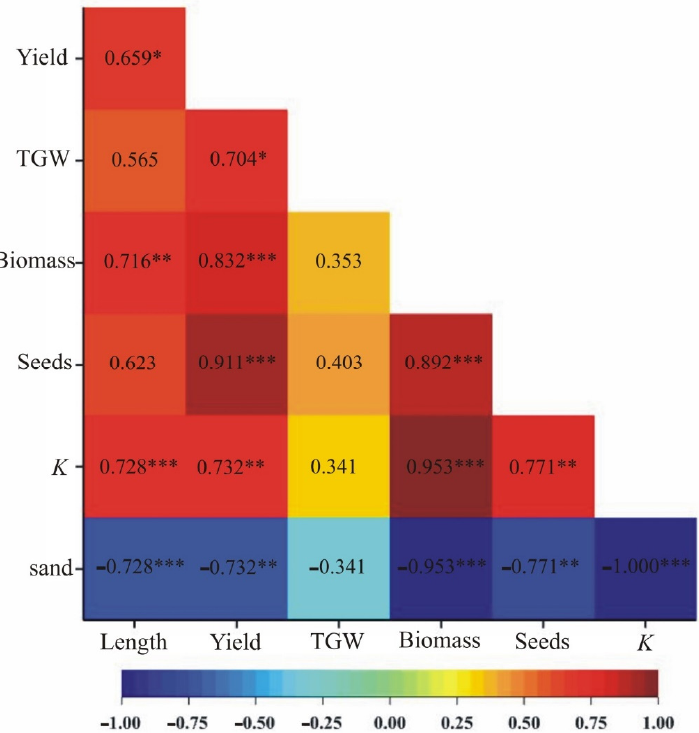
Figure 15. Heatmaps matrix for relationships between observed traits constructed on the basis of linear Pearson’s correlation coefficients, in 2019–2020 season. *, **, *** – significant at level 0.05, 0.01, 0.001, respectively.